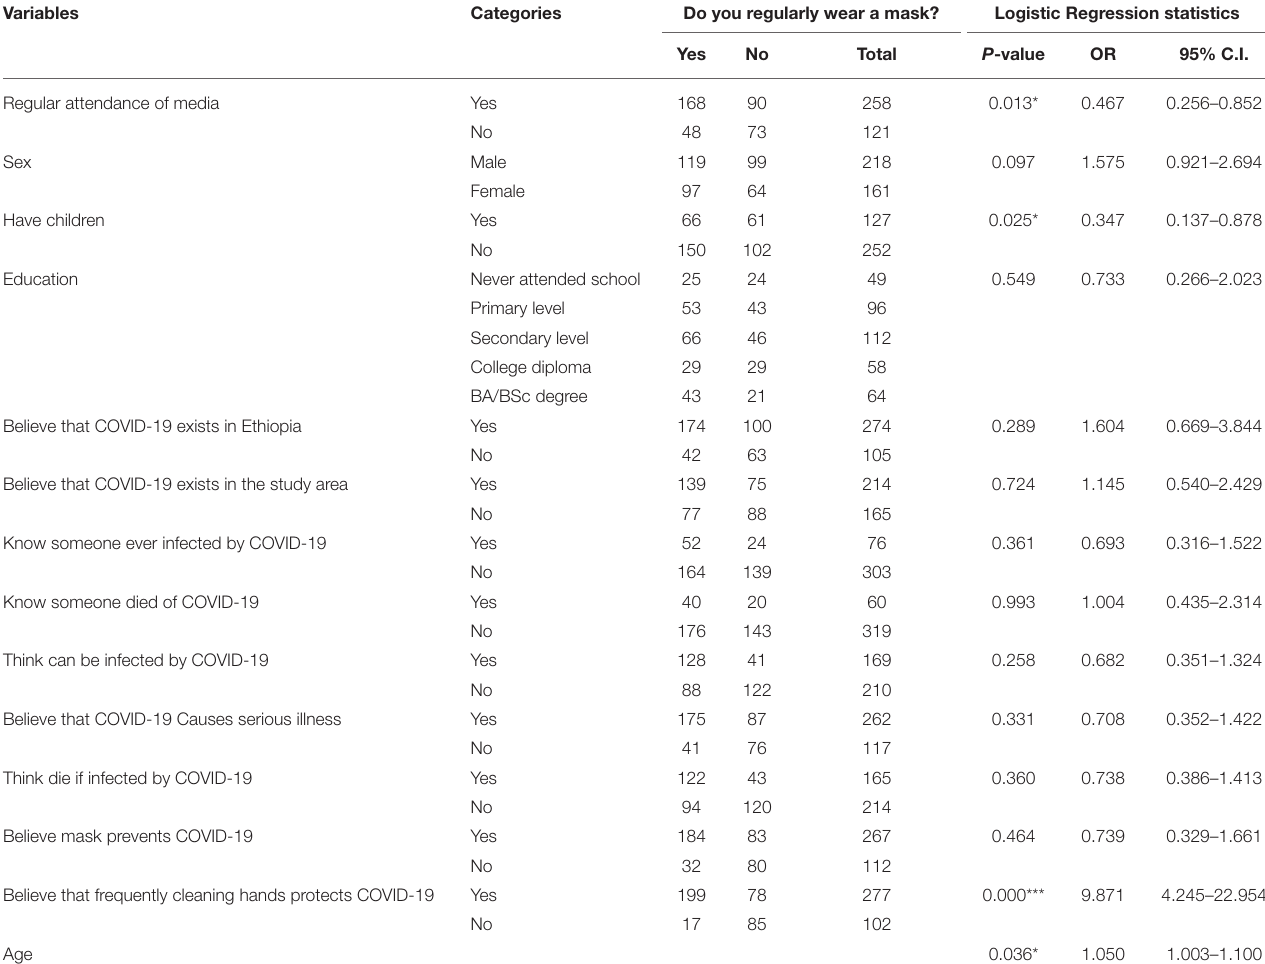
TABLE 6 | Binary logistic regression showing association between the socio-demographic characteristics of the respondents and practices of frequent hand wash.